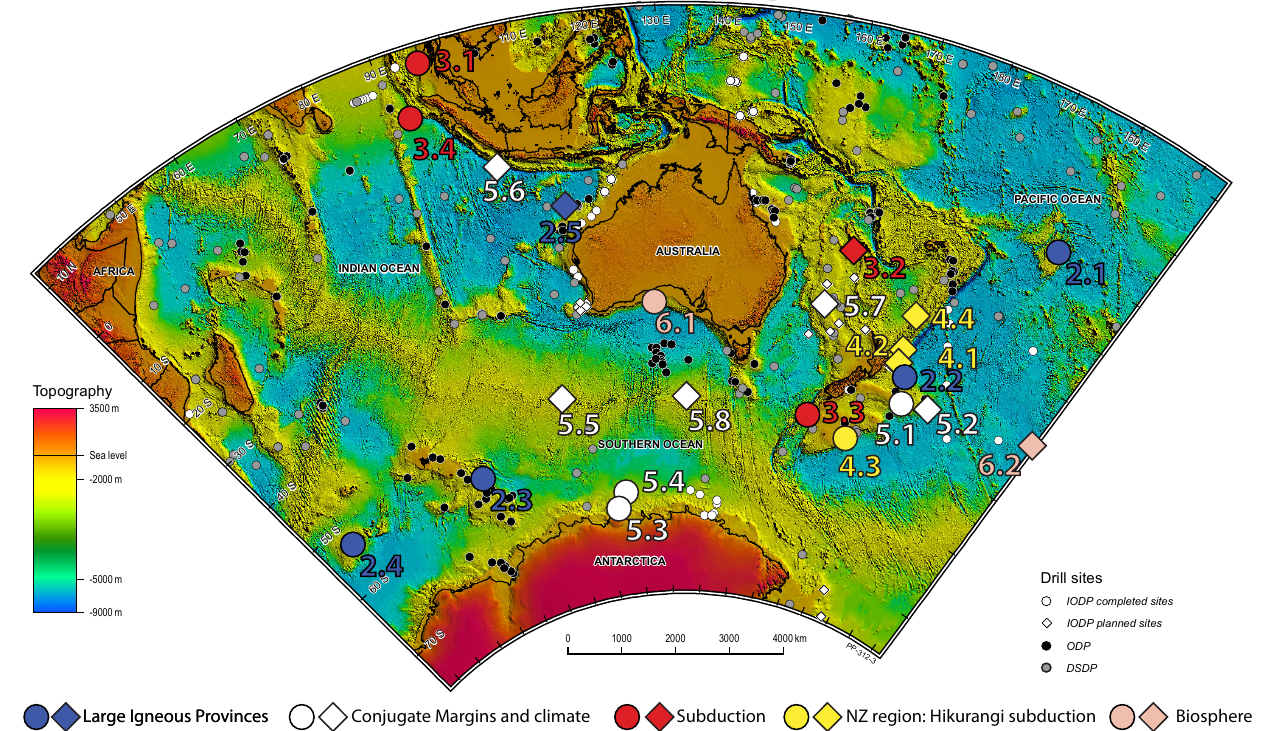
Figure 1. Location map of potential proposals discussed in the workshop, with color-coded dots denoting the main theme for each proposal. Small colored circles indicate previous (and planned) drilling by the Deep Sea Drilling Project (DSDP), Ocean Drilling Program (ODP), and IODP. Larger circles and diamonds are projects discussed in the meeting and are colored by theme, and numbered according to sections discussed in text. Large circles indicate proposals that appear mature enough to develop pre-proposals. Large diamonds require site survey proposals to be developed, or are awaiting the results of upcoming drilling in the region (e.g., Hikurangi subduction zone and Lord Howe Rise regions) and may require a focus workshop to further refine